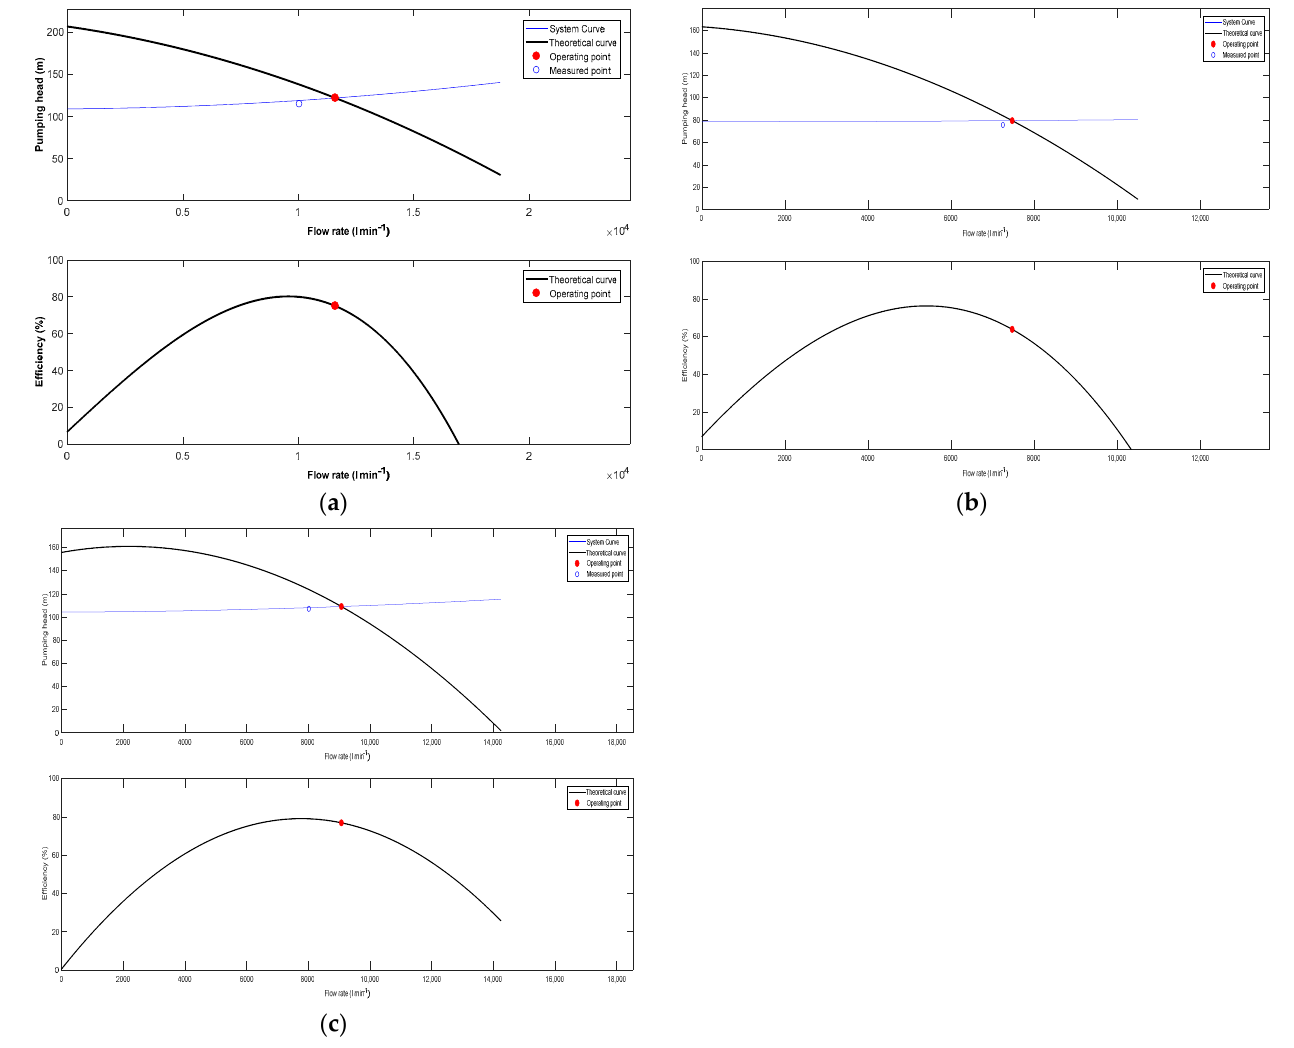
Figure 3. Characteristic curves H-Q, efficiency-Q, and operating point for Case 1 in WUA A ( a ), B ( b ), and C ( c ).